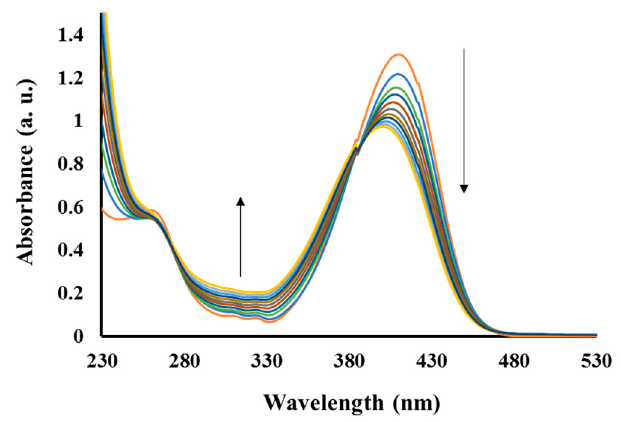
Figure 9. Changes in the absorption spectrum of monomer 6 (2 × 10 − 5 M) in acetonitrile upon the addition of Cu 2+ aliquots (0.025 M).